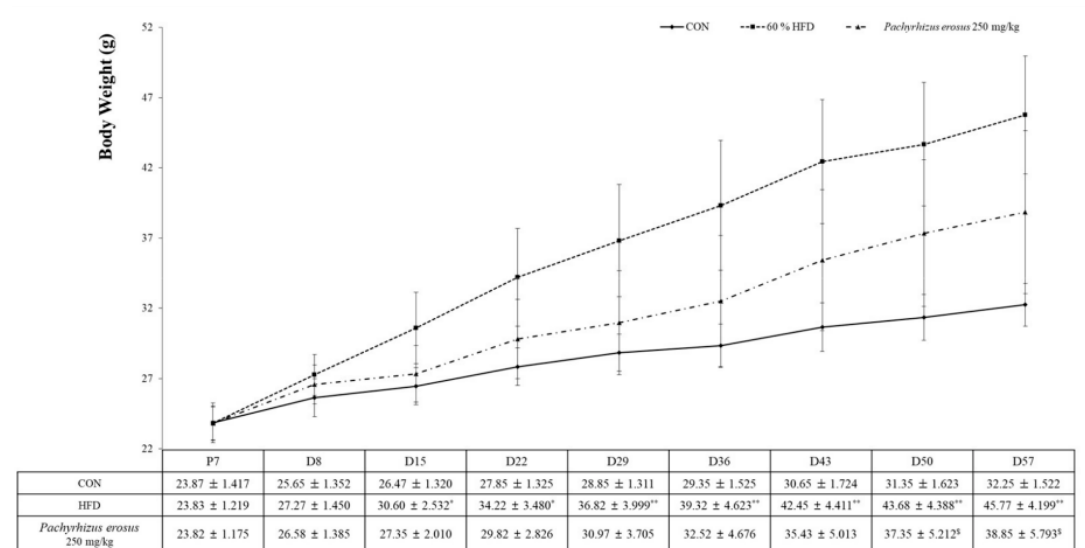
Figure 1. P. erosus decreased HFD-induced body weight gain. The differences in body weight between the three groups were observed from Day 15, and by Day 50, the body weight in the HFD treatment group was higher than that in the P. erosus treatment group. Compared to the body weight in the control group, the body weight in the HFD treatment group increased by 142%, but that in the P. erosus treatment group increased by 120%. That means that P. erosus has a protective effect against body weight gain due to HFD. Table in Figure 1. Body weight gain depends on the feeding period. The results are described as mean ± standard deviation. N = 12. * p < 0.05 vs. control; ** p < 0.001 vs. control; $ p < 0.05 vs. HFD-induced obesity.